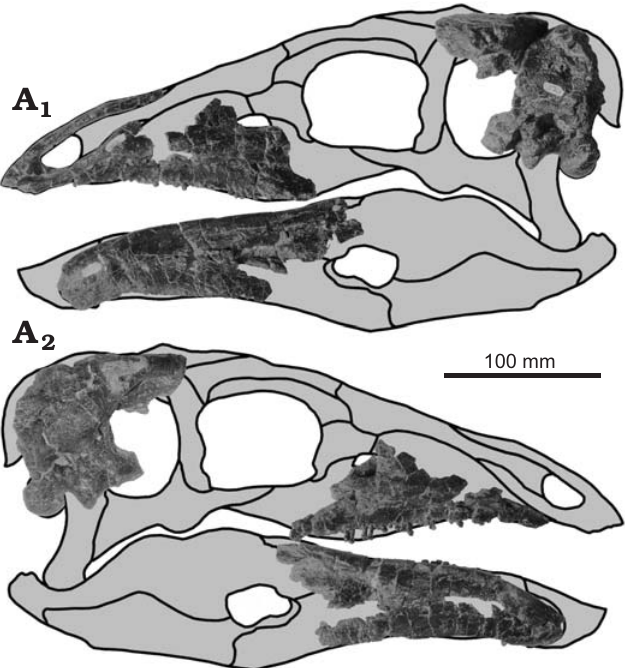
Fig. 6. Cranial elements of stegosaur GPDM 178, near Giffen, Cascade County, Montana, USA; in left (A 1 ) and right (A 2 ) lateral views; gray, missing elements.